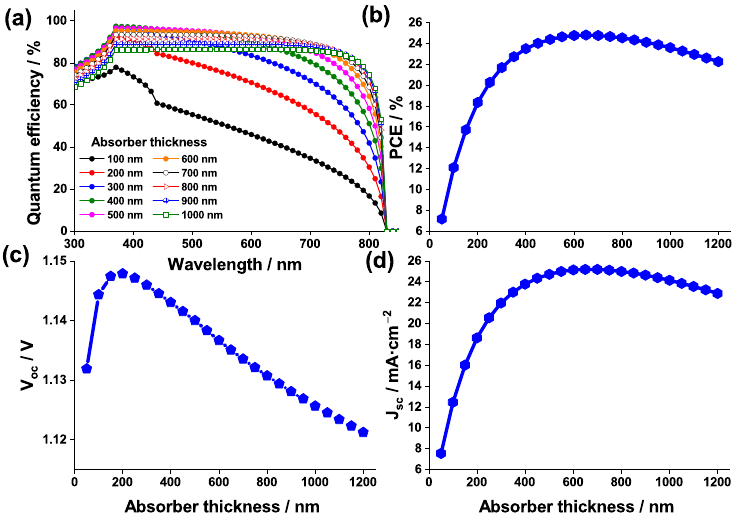
Figure 12. Effect of the absorber thickness on ( a ) the quantum efficiency of the PSC, ( b ) PCE, ( c ) V oc , and ( d ) J sc